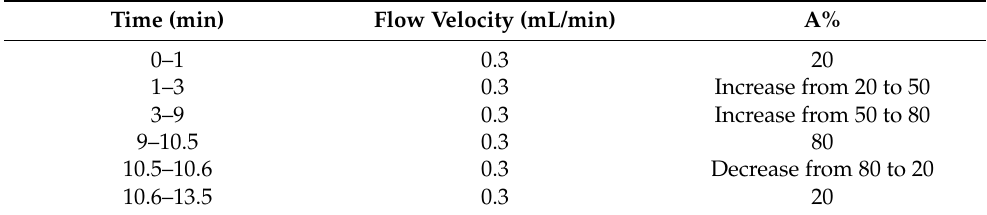
Table 2. Gradient Parameters of